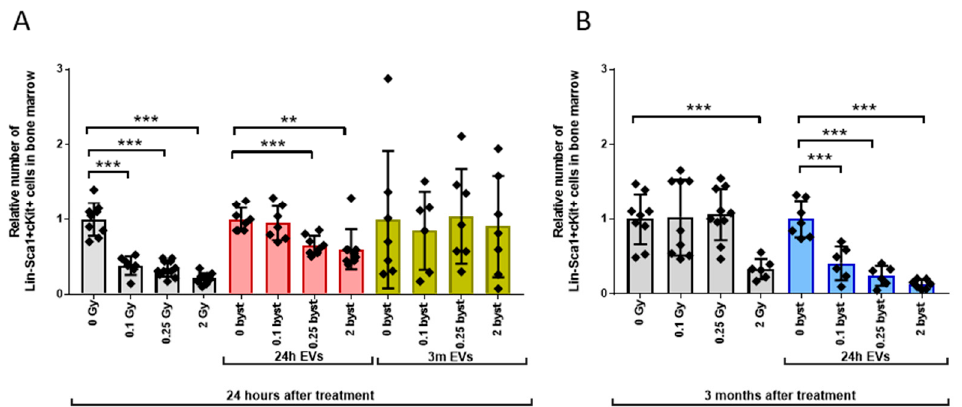
Figure 4. Bone Marrow-Derived Extracellular Vesicles from Irradiated Mice Induce Long-Term Hematopoietic Stem Cell Depletion in the Bone Marrow of Bystander Mice. Irradiation, extracellular vesicle treatment and bone marrow cell phenotyping were carried out as described in the Materials and Methods section. Lin-Sca1+cKit+ cells were considered hematopoietic stem cells. ( A ) Relative changes in hematopoietic stem cell numbers were evaluated 24 h after treatment. Grey bars represent total-body irradiated mice; red bars represent mice treated with bone marrow-derived extracellular vesicles isolated from mice 24 h after irradiation; yellow bars represent mice treated with bone marrow-derived extracellular vesicles isolated from mice 3 months after irradiation. ( B ) Relative changes in hematopoietic stem cell numbers were evaluated 3 months after treatment. Grey bars represent total-body irradiated mice; blue bars represent mice treated with bone marrow-derived extracellular vesicles isolated from mice 24 h after irradiation. Bars represent mean values of relative hematopoietic stem cell numbers, dots show individual values, error bars represent SD. n = 6–11, significance tested by Student’s t -test, p ** < 0.01, p *** < 0.001.